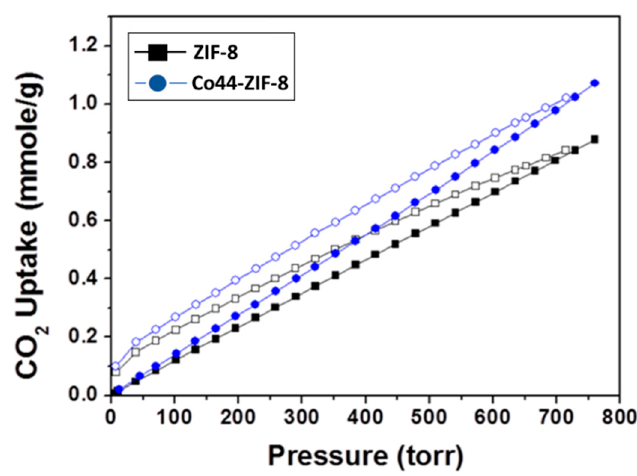
Figure 12. CO 2 adsorption–desorption of ZIF-8 and Co44-ZIF-8.